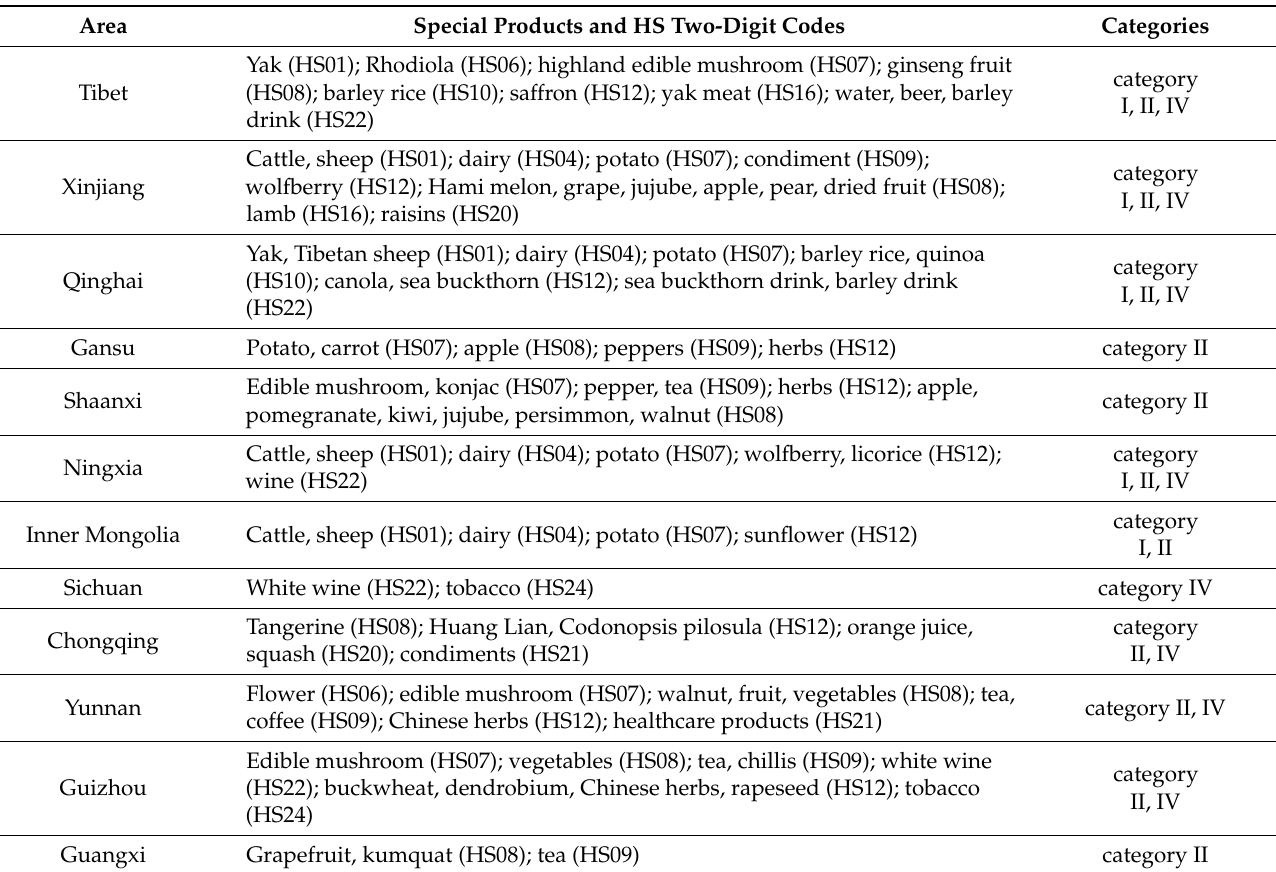
Table 2. Important categories of agricultural products in the western